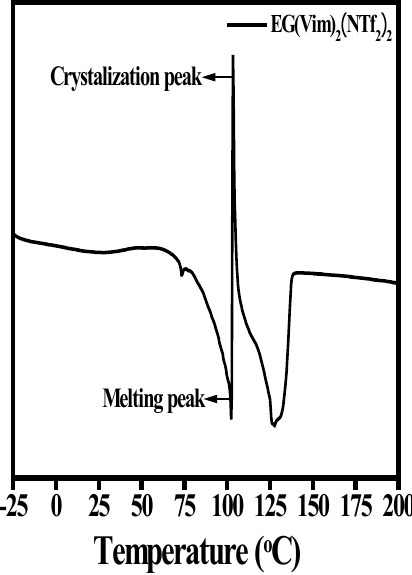
Figure 2: Differential scanning calorimetry (DSC) analysis of synthesized di-cationic RTILs.